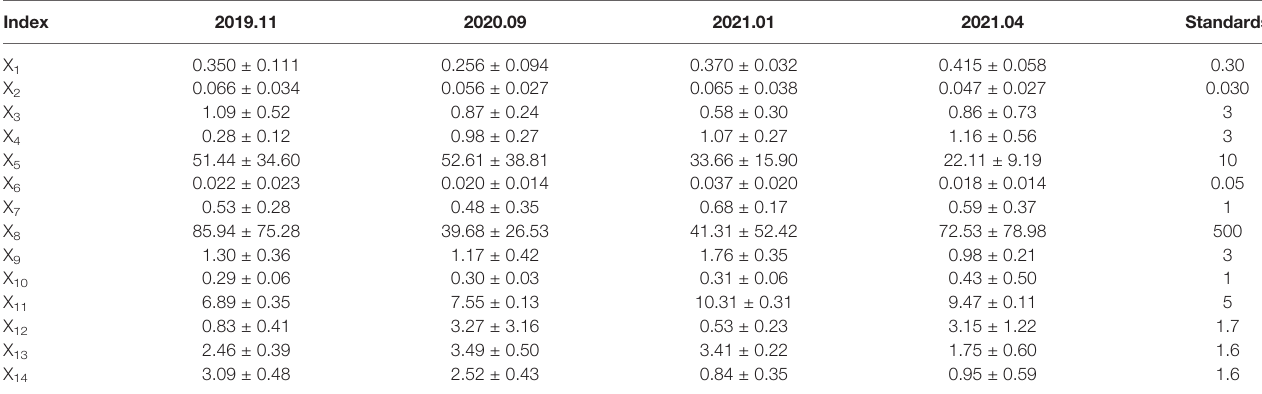
TABLE 4 | The monitoring results of ecological environment in Dachen